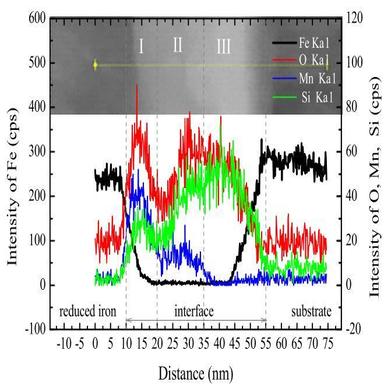
TEM EDS elemental line scanning of the oxidized-reduced sample.